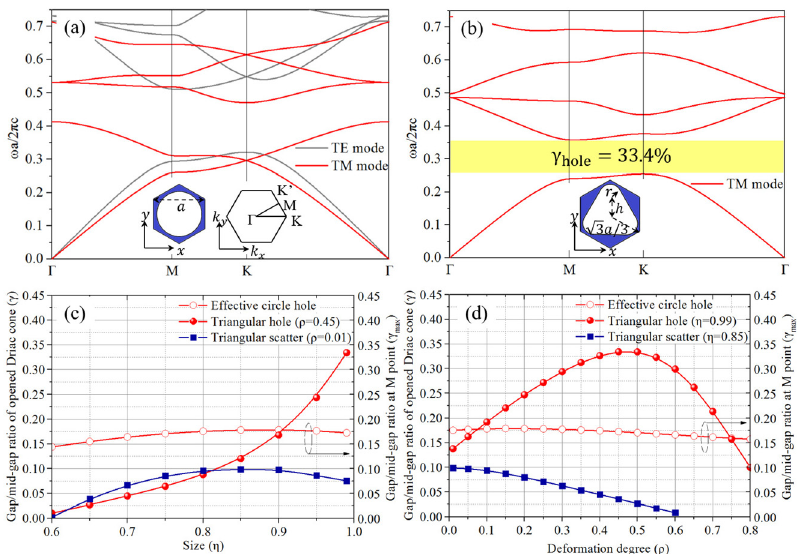
(Figure 2a) and the unit area, respectively. According to Figure 1c, the gap/mid-gap ratio of the VPC with triangular (cid:1) 33 . 4% for η (cid:1) 0 . 99 air holes has a maximum value of γ hole and ρ (cid:1) 0 . 45. In contrast, when considering the VPC with a honeycomb lattice constructed by the triangular solid Si scatters, the bands contributed from the TE mode form a larger gap than the TM mode. The theoretical maximum (cid:1) 10% for η (cid:1) 0 . 85 and ρ (cid:1) 0 . 01. gap/mid-gap ratio is γ solid In order to explain that the gap/mid-gap ratio of the VPC with air hole arrays can be much larger than the VPC with solid scatter arrays, we consider the following low-energy Hamiltonian at Dirac points [16]: